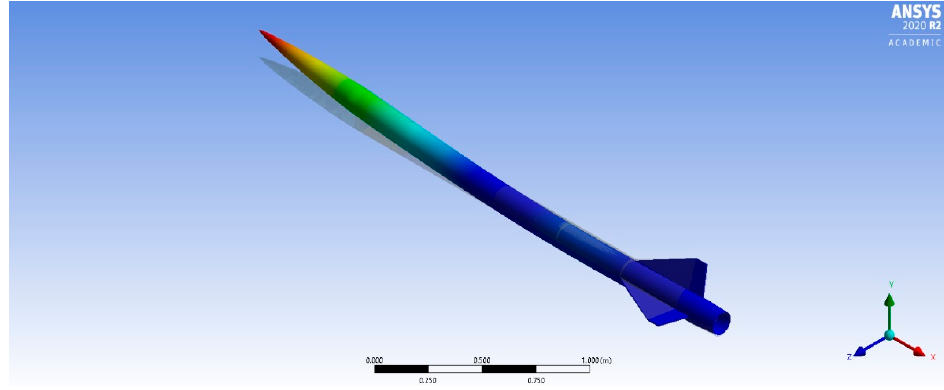
Figure 28. First-Order Bending Mode Shape (X–Y Plane).